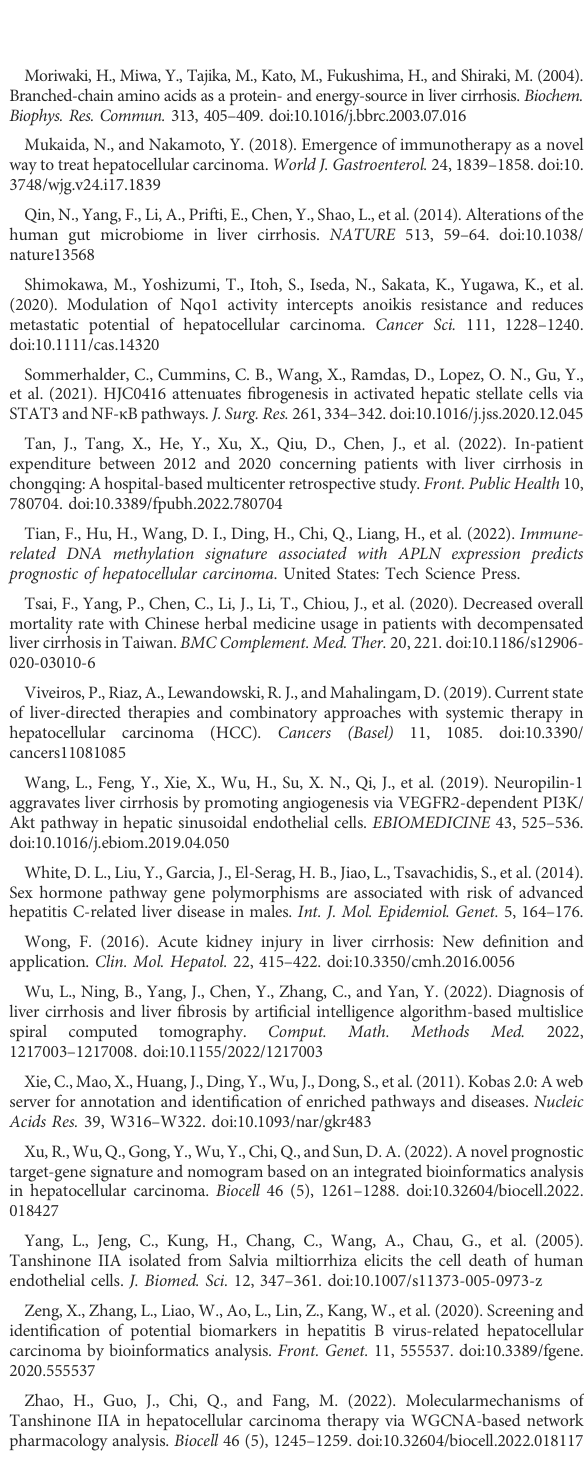
TPX2 siRNAs. Right panel: statistical anaylsis results of migration distancepercentage,scalebar:400 μ m. (C) Trans-wellassayofcellsafter knockdown of AKR1C3 or TPC2. (D) Statistical analysis of invasive cells, data was shown as percentage. Five views was calculated for each group. Each experiment has been repeated for at least 3 times. *, p < .05; **, p <